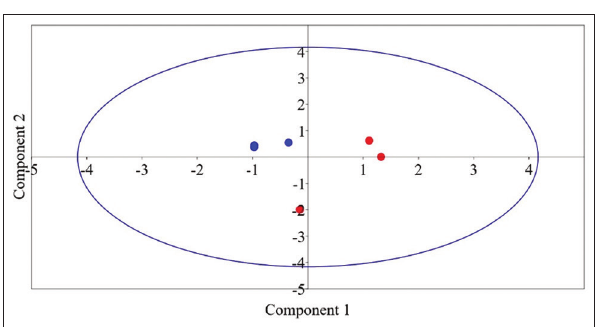
Figure-1: Principal component analysis of rumen bacterial community based on Bray-Curtis dissimilarity in the rumen of camels fed different forage types. The blue circles for camels fed barley straw and red triangle for camel fed clover